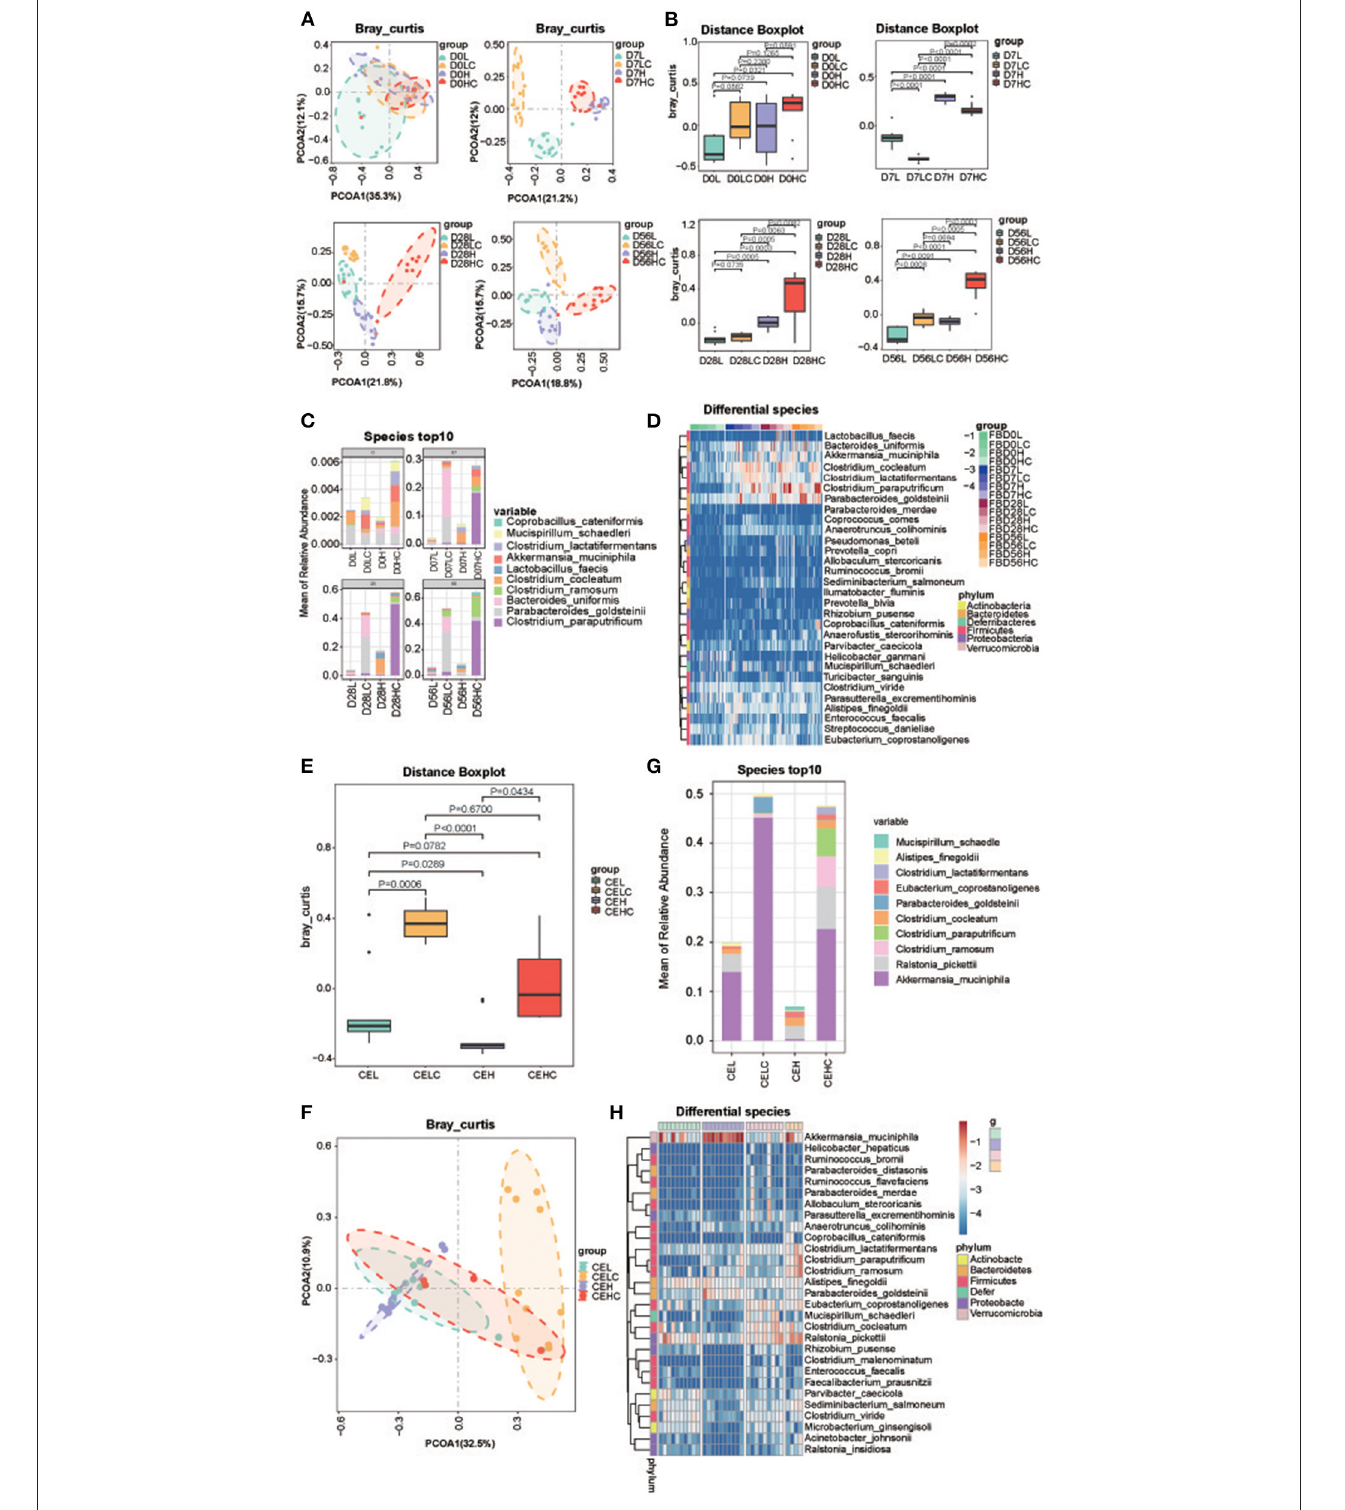
FIGURE 3 | Structure of the gut microbiome. (A) PCOA analysis of the fecal microbiota; (B) Bray Curtis distance of the fecal microbiota; (C) Top 10 dominant fecal microbes over time in each group; (D) Heatmap of differential fecal species at the same time point; (E) PCOA analysis of the cecum microbiota; (F) Bray Curtis distance of the cecum microbiota; (G) Top 10 dominant fecal microbes over time in each group; (H) Heatmap of differential cecum microbes at the same time point. Groups: Group L (low-fat diet group, fed with 4.3% fat, 5% cellulose); LC group (low-fat diet + COS group, fed with 4.3% fat, 5% COS); group H (high-fat diet group, fed with 35.4% fat, 5% cellulose); and HC group (high Fat diet + COS group, fed with 35.4% fat, 5% COS).